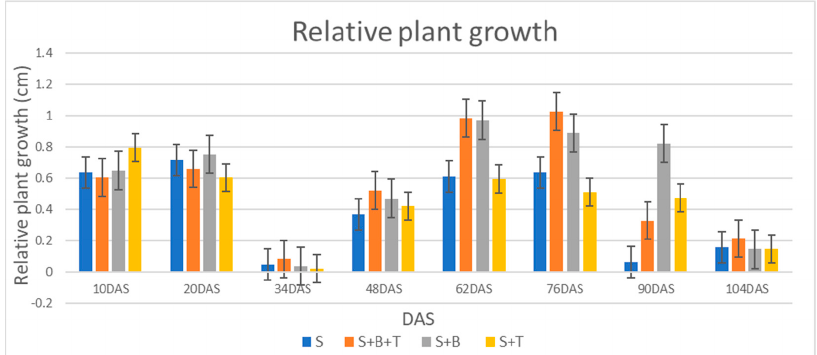
Figure 3. Comparison of relative plant heights of uninoculated control, treatment co-inoculated Bradyrhizobium and Trichoderma , treatment inoculated with Bradyrhizobium only, and treatment inoculated with Trichoderma alone. RPH in centimeter was analyzed at 14-day interval.